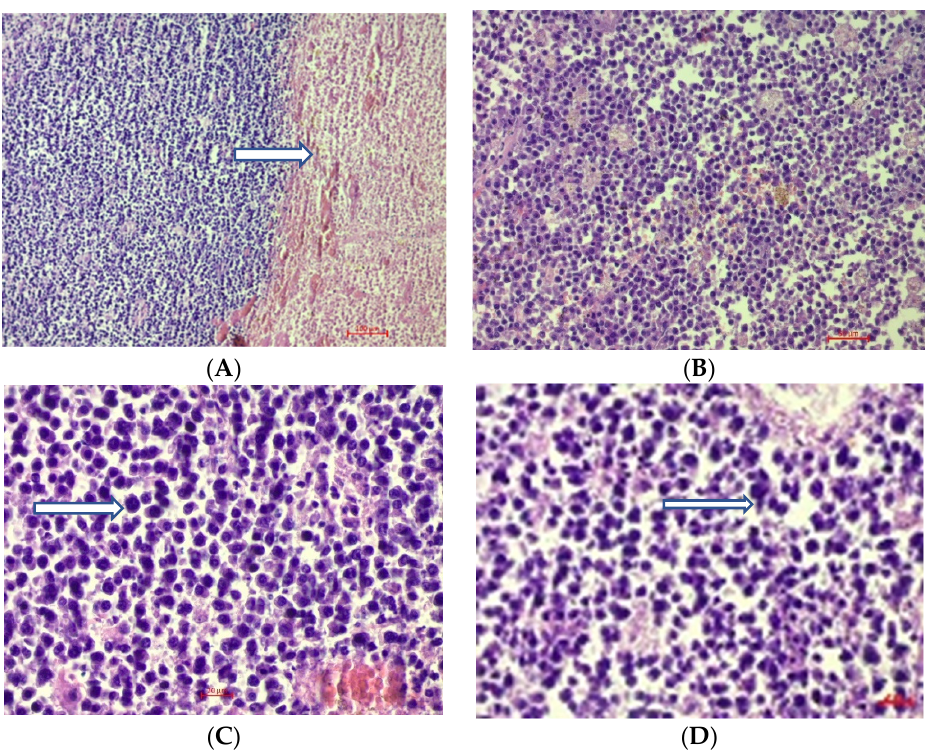
Figure 4. Hematoxylin and eosin staining of formalin-fixed, paraffin-embedded sections of the tumor at: ( A )—10× magnification with necrotic area (arrow); ( B )—20× magnification; ( C , D )—40× magnification, showing the proliferation of plasma cells with pleomorphism and enlarged nuclei with clear cytoplasms (arrow).